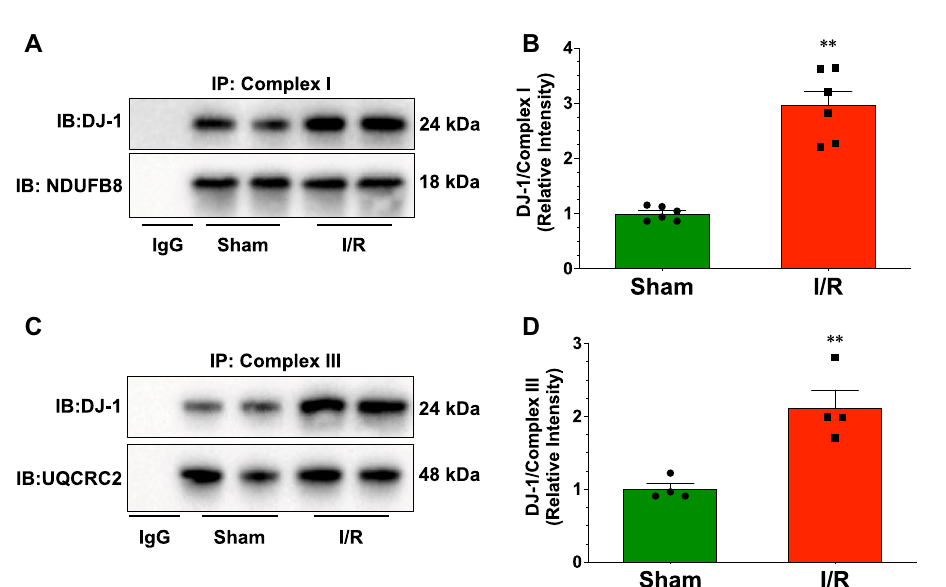
Figure 3. Ischemia–reperfusion injury enhances the interaction of DJ-1 with complex I and complex III of the mitochondrial electron transport chain. ( A ) Immunoblots and ( B ) analysis of the interaction between DJ-1 and complex I of the mitochondria electron transport chain. ( C ) Immunoblots and ( D ) analysis of the interaction between DJ-1 and complex III of the mitochondria electron transport chain. Measurements were performed in samples collected at 3 days of reperfusion from Wild-Type mice. Values are means ± SEM. 4–6 samples per group. Student’s t test. ** p < 0.01 vs.